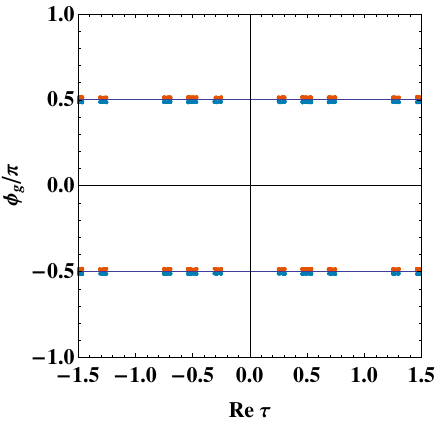
Figure 4 . The allowed regions of Re (cid:28) and phase (cid:30) g . Red and blue points correspond to the positive and negative signs of the BAU, respectively.